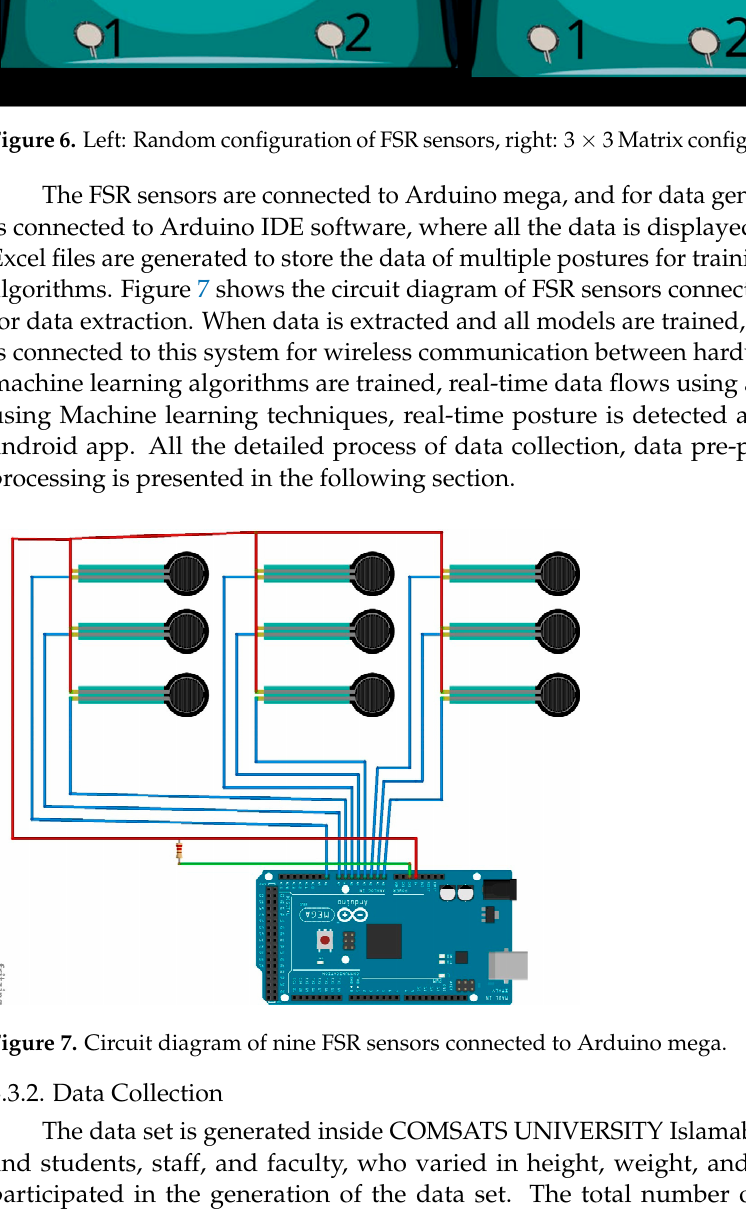
Figure 7. Circuit diagram of nine FSR sensors connected to Arduino mega.